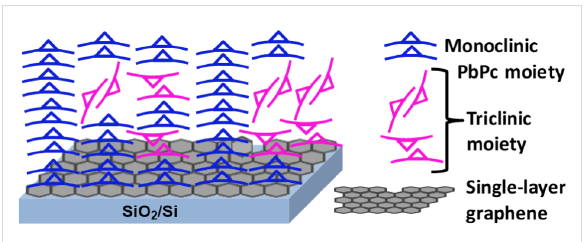
Figure 4: Schematic showing the molecular orientation of PbPc mole- cules on SLG/SiO 2